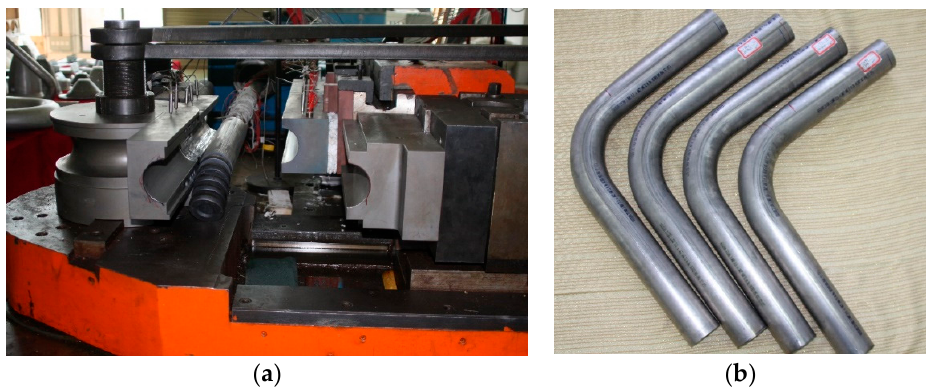
Figure 5. Warm bending experiment of CP-Ti tubes: ( a ) experimental platform; ( b ) typical experi- mental bent tubes.